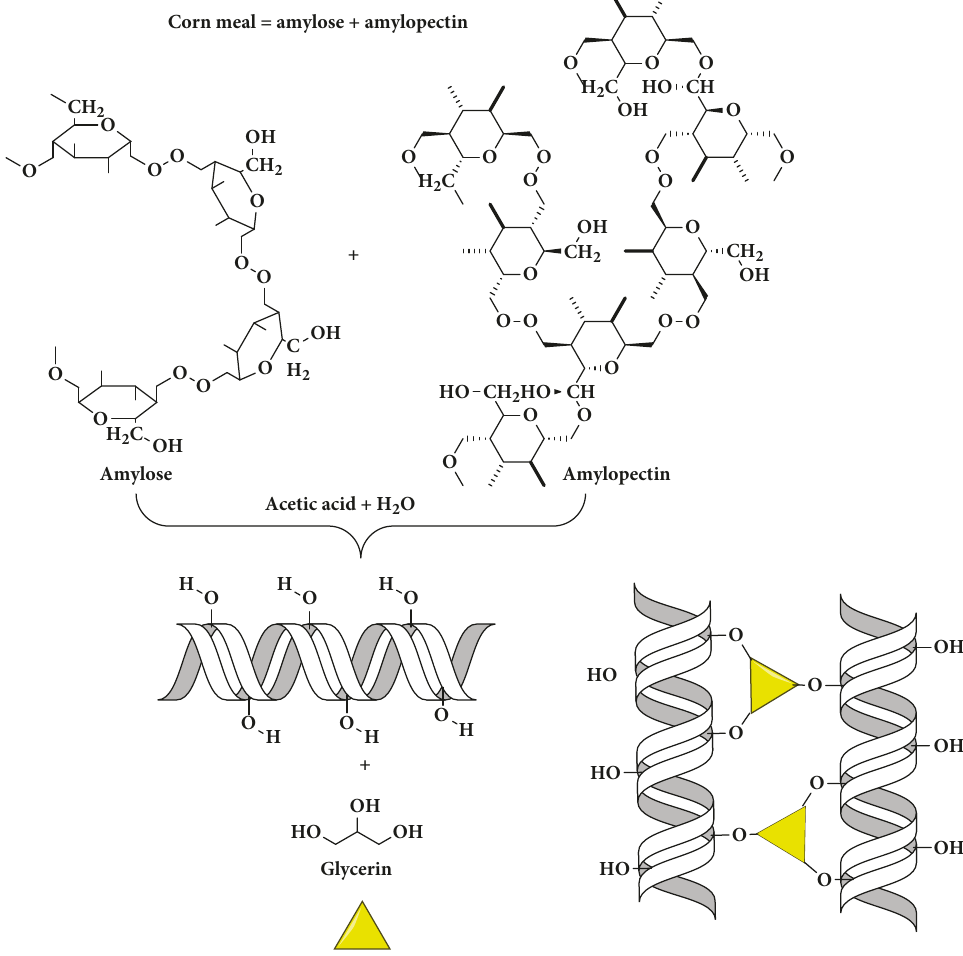
Figure 2: The tentative reaction